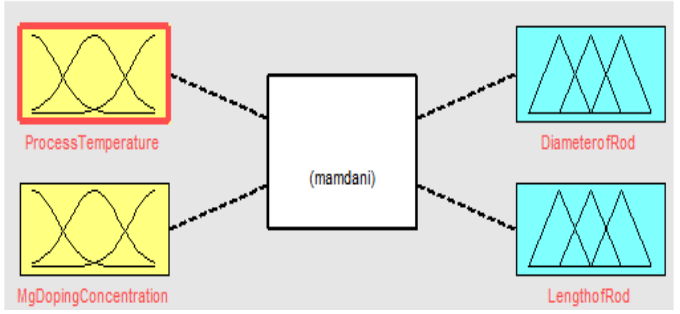
Fig. 2. FLC Interface for 2 Inputs and 2